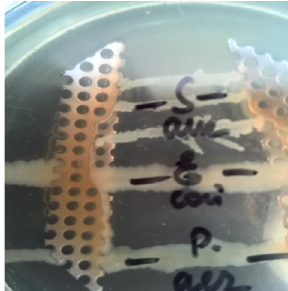
are carried out in bacterial suspensions and by the disc diffuse method, when the release of the active antibacterial form from the modified surface leads to growth retardation [6]. After diffusion into the surrounding tissue, the “active” surface is depleted and ceases to impede the development of microflora